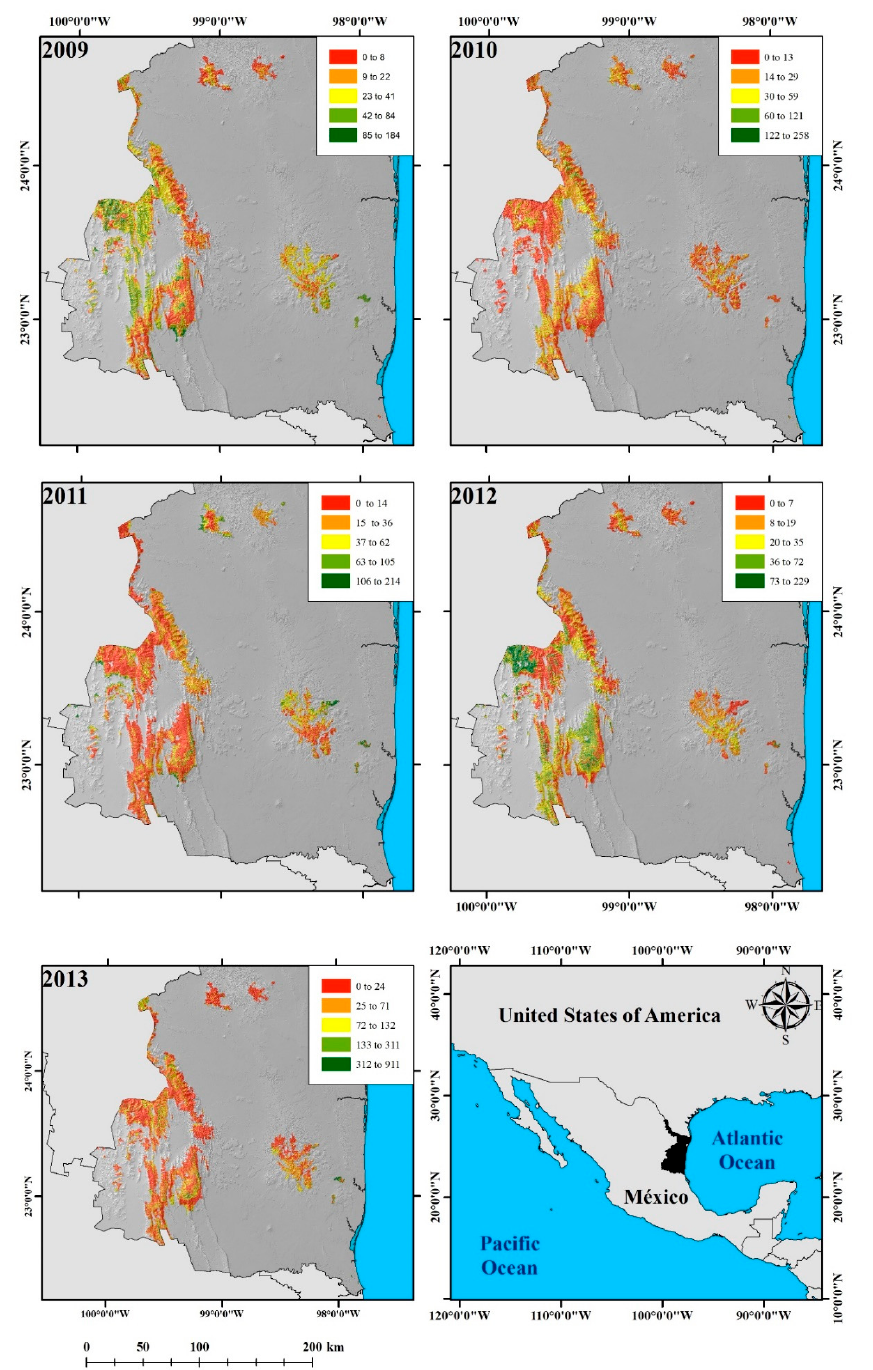
Figure 4. Maps of predicted average fuel load in the temperate forest ecosystem for 2009, 2010, 2011, 2012, and 2013 obtained in Tamaulipas,